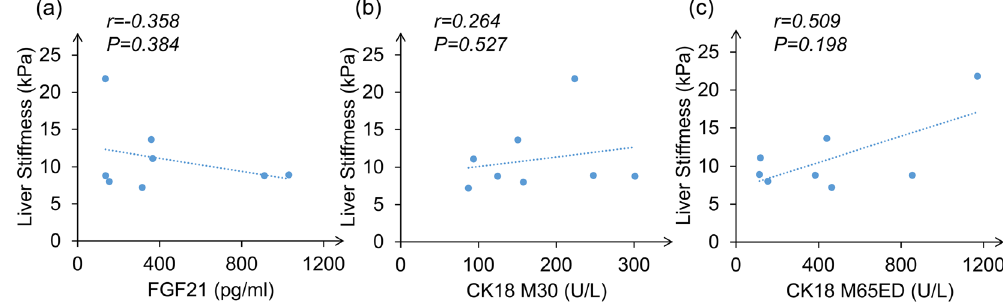
Figure 3. Relationship between baseline FGF21, CK18 M30 and CK18 M65ED with liver stiffness after 8-year follow-up. ( a ) Correlation of baseline FGF21 levels and liver stiffness evaluated by FibroScan after 8-year follow-up. ( b ) Correlation of baseline CK18 M30 levels and liver stiffness. ( c ) Correlation of baseline CK18 M65ED levels and liver